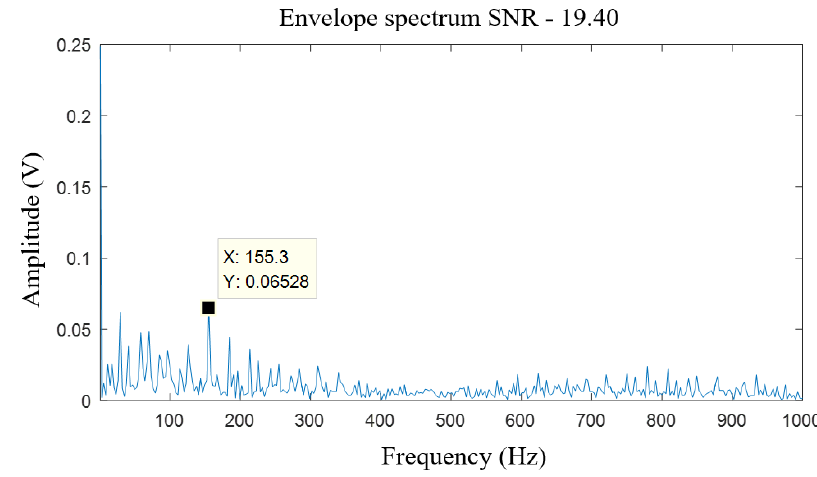
Figure 14. The envelope spectrum of original signal.